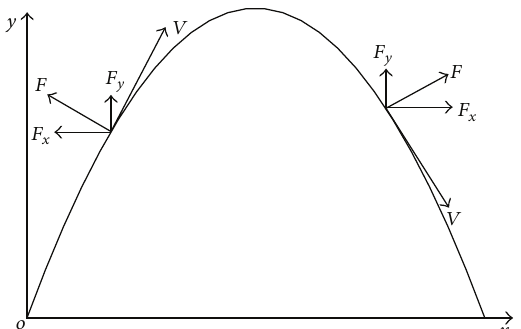
Figure 9: Schematic of aerodynamic force caused by canards deflection (optimized method).